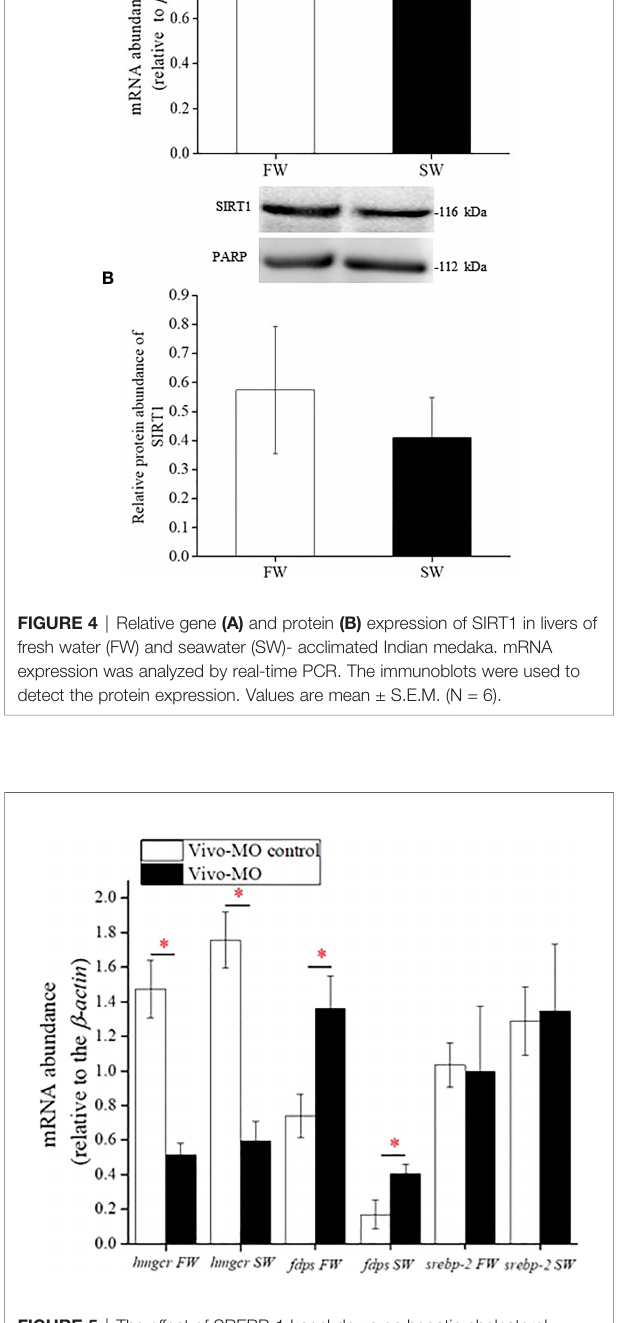
FIGURE 5 | The effect of SREBP-1 knockdown on hepatic cholesterol content in fresh water (FW)- and seawater (SW)-acclimated Indian medaka. (A) The speci fi city test of SREBP-1 Vivo-MO. (B) The measurement of hepatic cholesterol content in Indian medaka with/without SREBP-1 knockdown. Values are mean ± S.E.M. (N = 6). Student ’ s t-test, *p < 0.05.